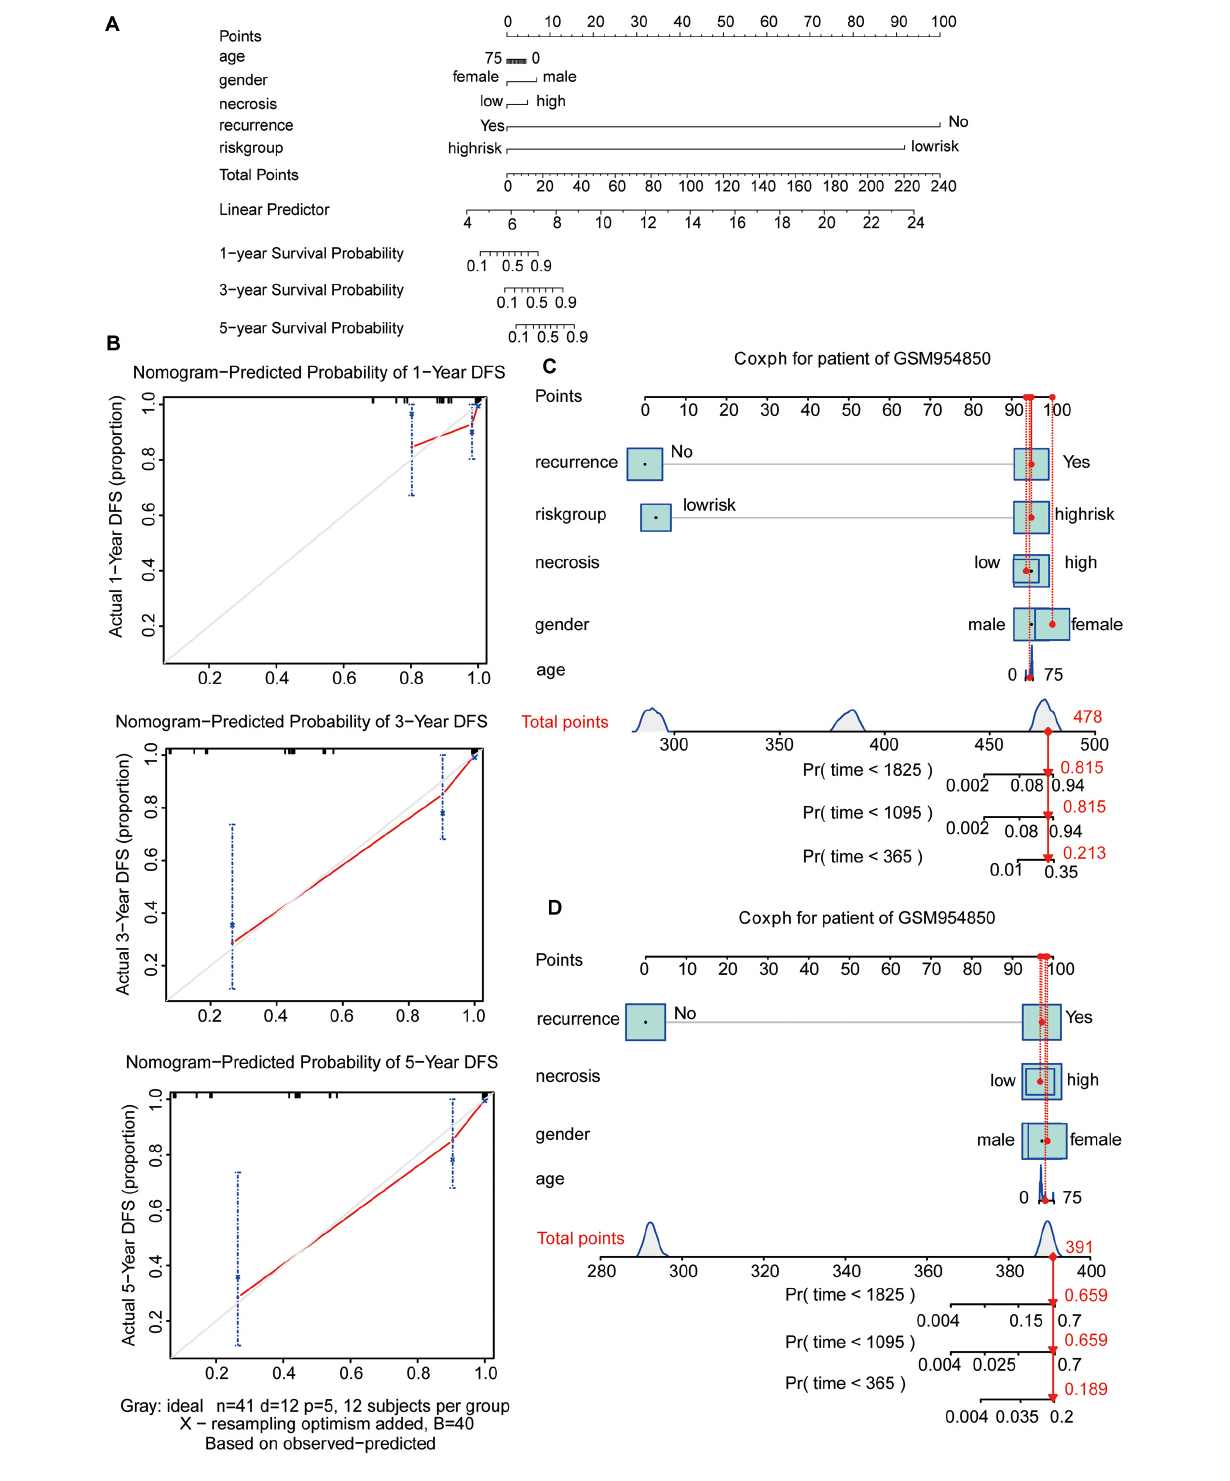
FIGURE 5 | Nomogram predicting the probability of 1-, 3-, and 5-year OS in patients with osteosarcoma. (A) Nomogram adding up the points identified on the points scale (the upward line) for each variable. The total points projected on the bottom scales indicate the probability of 1-, 3-, and 5-year OS. (B) Calibration plot for predicting the 1-, 3-, and 5-year OS. The gray line represents the ideal condition. (C , D) The nomograms predicting the probability of 1-, 3-, and 5-year OS for the specific patient GSM954850 based on the model containing or not containing the risk group in the GSE39058 dataset. OS, overall survival; DFS, disease-free